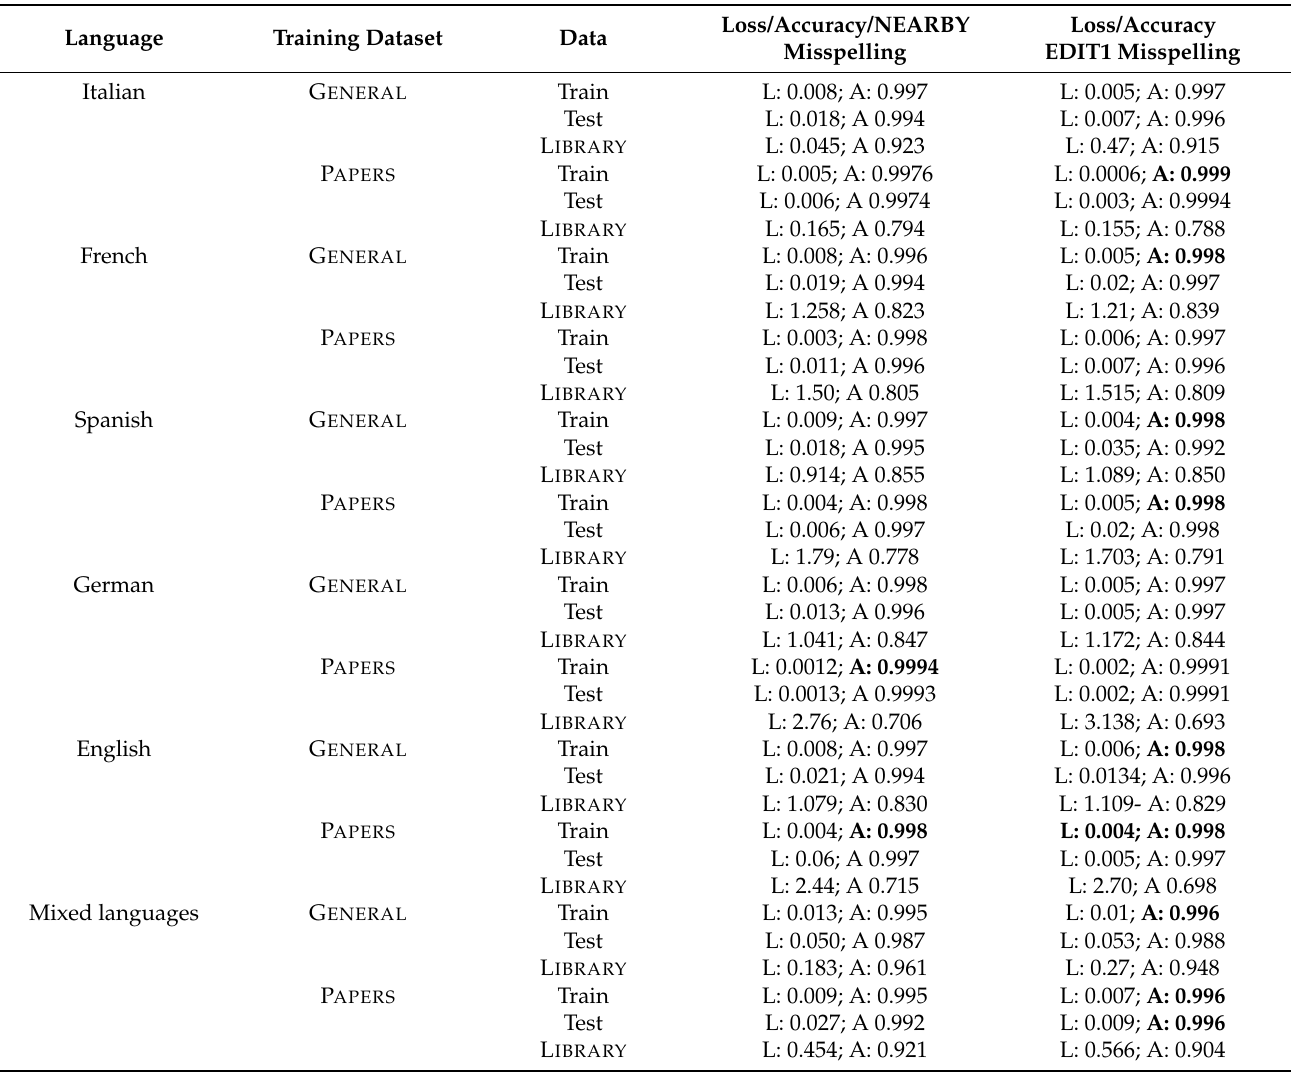
Table 7. Accuracy values for the statistical approach to misspelling